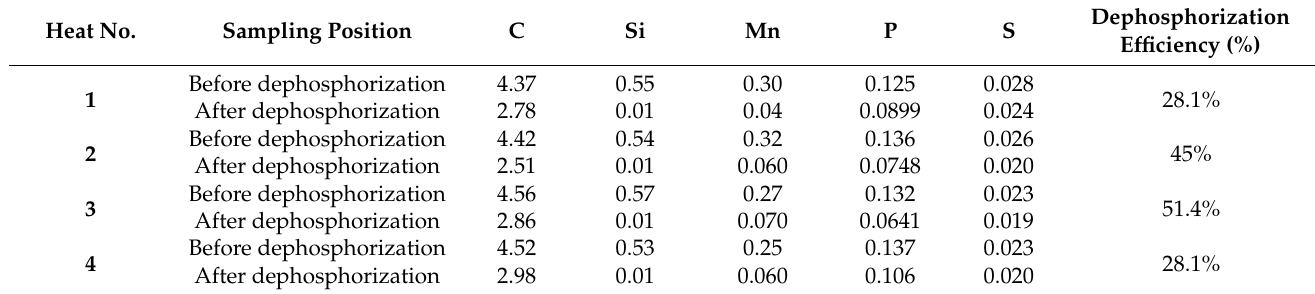
Table 2. Compositions of hot metal before and after dephosphorization.